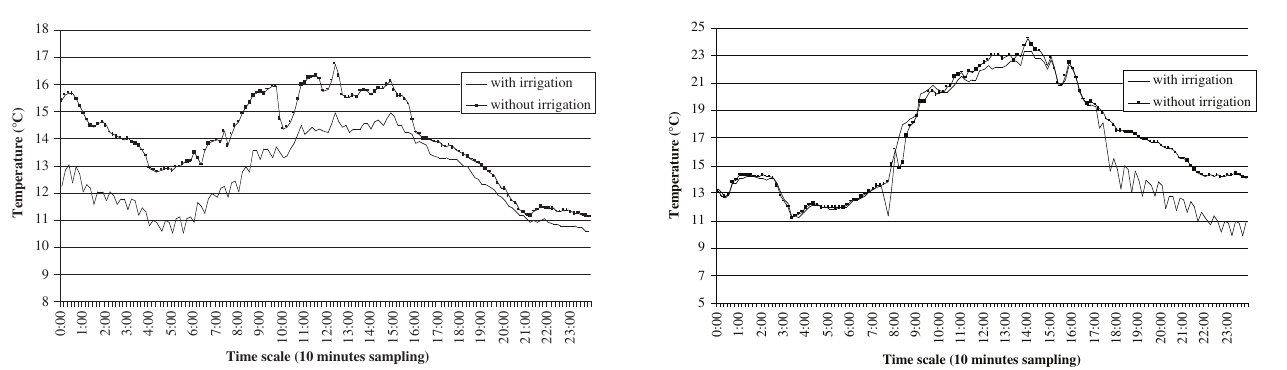
Figure 2. Effect of irrigation those days when the night temperature (T>10 °C) and wind speed (Vaverage >10 m/s) was high.between March 15 and